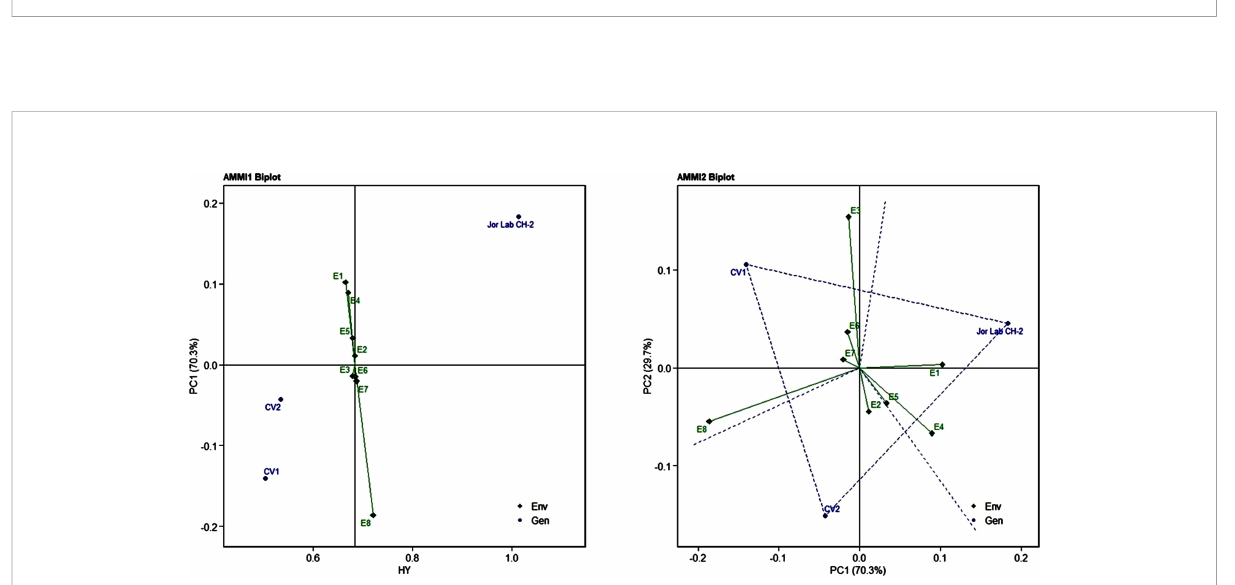
(Table 4). Trans anethole is an ethanol soluble volatile